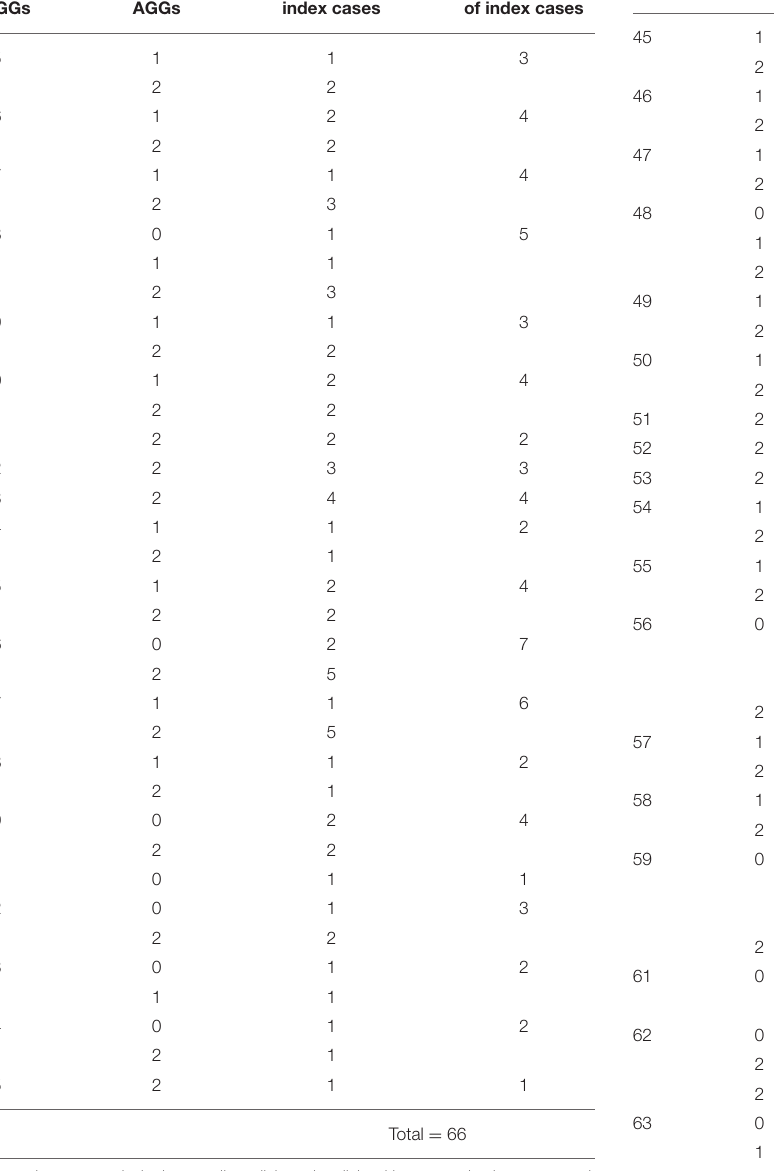
TABLE 1 | Results of triplet studies indicating CGG repeats and AGG interruptions in index cases. Maternal Maternal CGGs AGGs